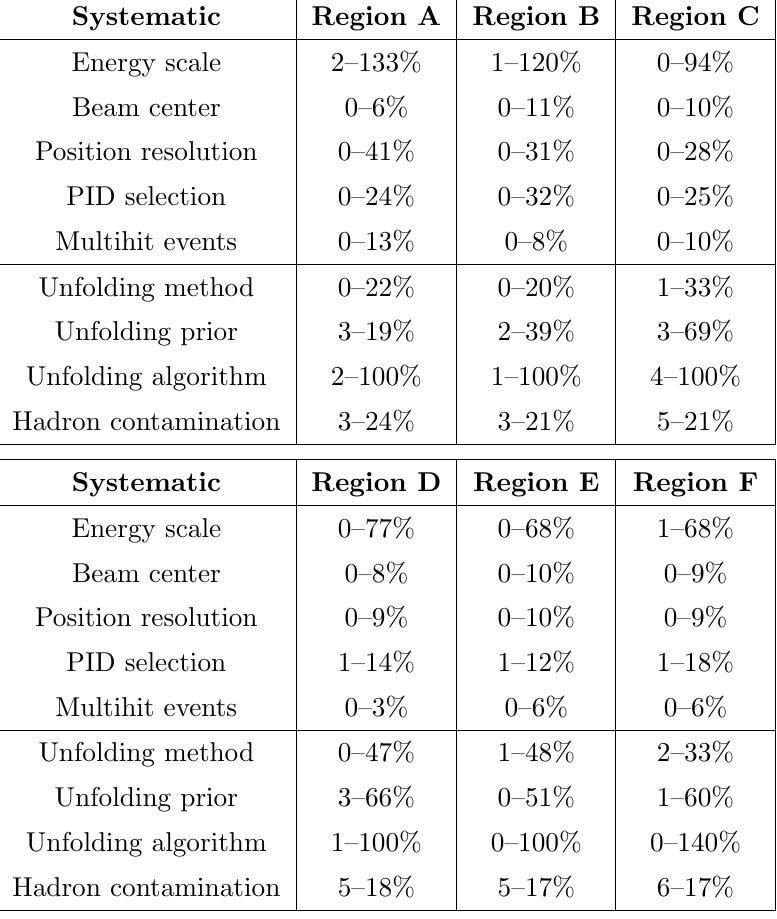
Table 3 . The (minimum, maximum) values of the relative systematic uncertainties for each con- tribution discussed here, separately reported for regions A, B, C, D, E and F. The top (cid:12)ve and the bottom four uncertainties are respectively applied before and after unfolding. Note that the two energy independent systematic uncertainties, relative to integrated luminosity (1 : 9%) and detection e(cid:14)ciency (6%), applied after unfolding, are not reported in this